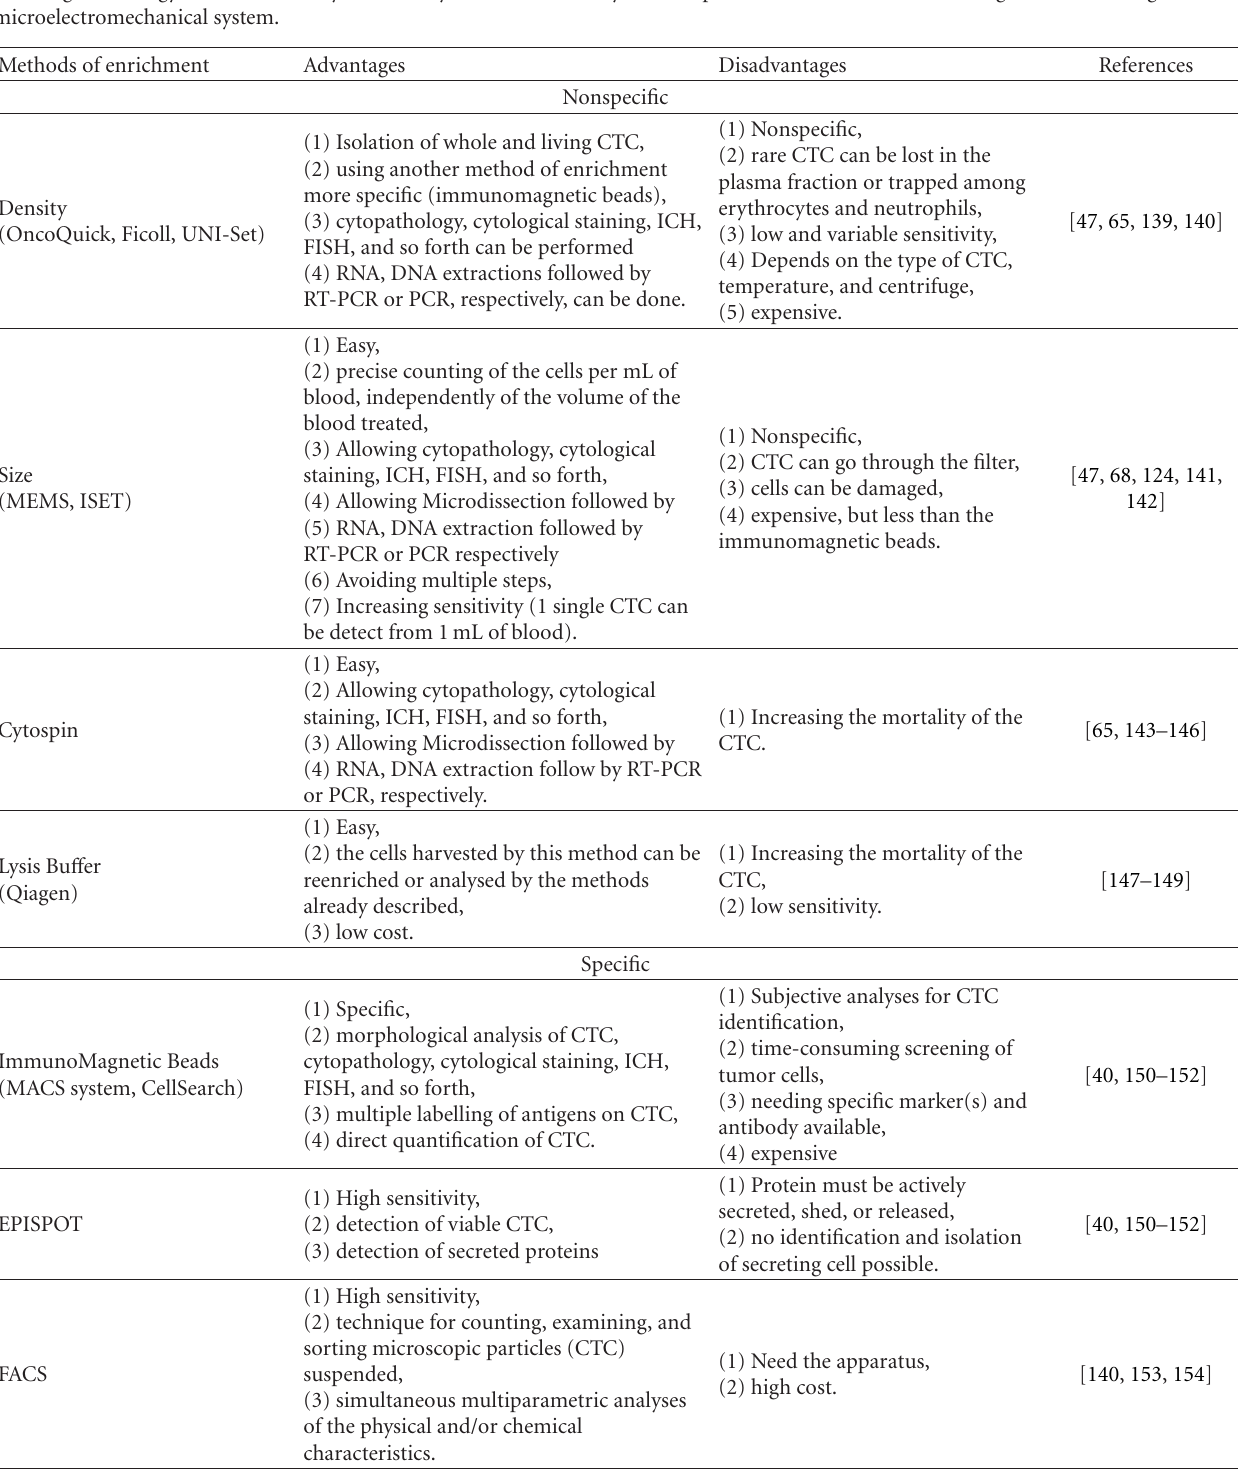
Table 2: Summary of advantages and disadvantages of the methods of CTC enrichment. CTC, circulating tumor cell; CTC-Chip, circulating tumor cell chip; EPIPSPOT, epithelial immunospot; FACS, fluorescence-activated cell sorting = flow cytometric; FAST, fiber-optic array scanning technology; ICH, immunocytochemistry; ISET, isolation by size of epithelial tumor cells; MACS, magnetic cell sorting; MEMS, microelectromechanical